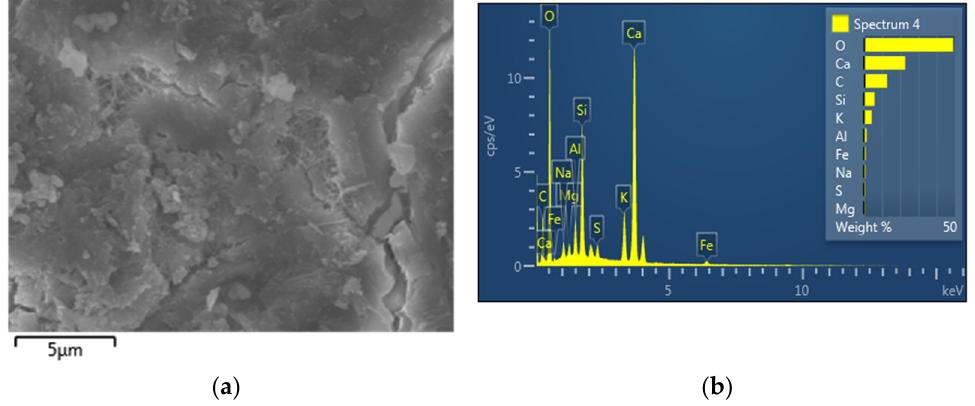
Figure 13. EDS results of cement paste containing CNT-TEOS/PVP NFs: ( a ) SEM image; ( b ) EDS spectrum.